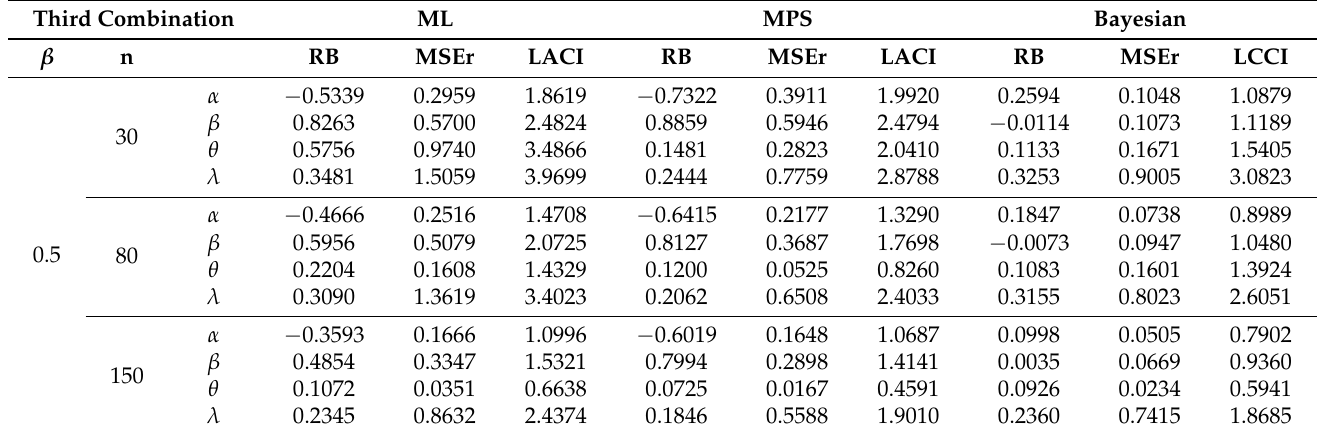
Table 6. ML, MPS, Bayes estimation methods: RB, MSE, LACI and LCCI at third